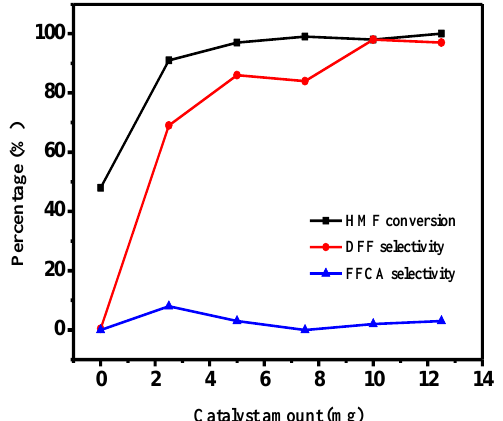
Figure 6. Effects of the catalyst amount on the oxidation of HMF to DFF. HMF (25.2 mg, 0.2 mmol), and DMSO (2 mL) for 10 h at 120 °C in air.